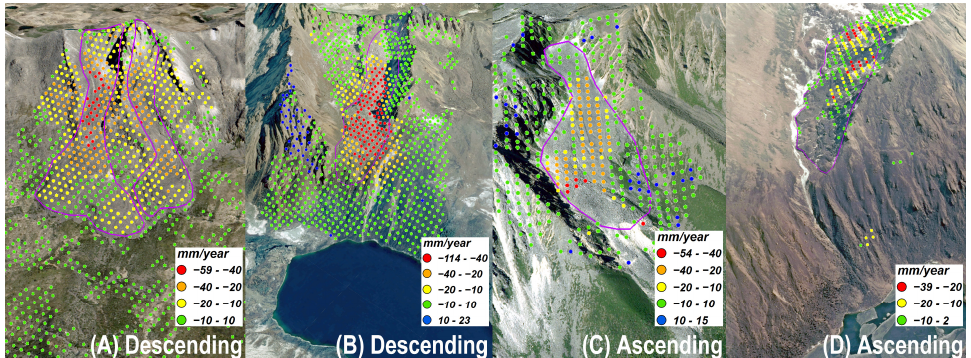
Figure 8. LOS velocity of typical debris avalanches. The base map is the Tianditu images with a spatial resolution of 1 meter. The purple line represents the boundary of debris avalanches.